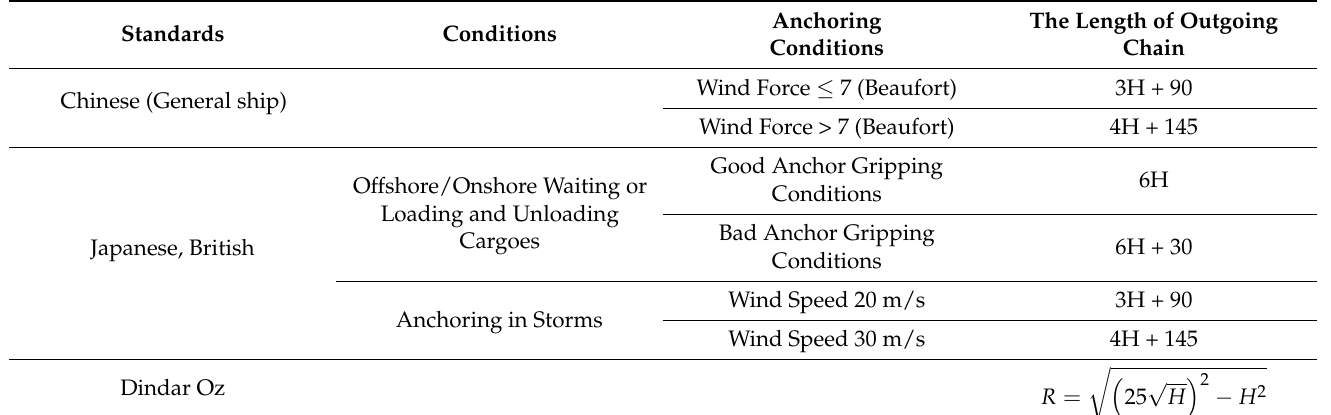
Table 1. Length of outgoing chain proposed by different